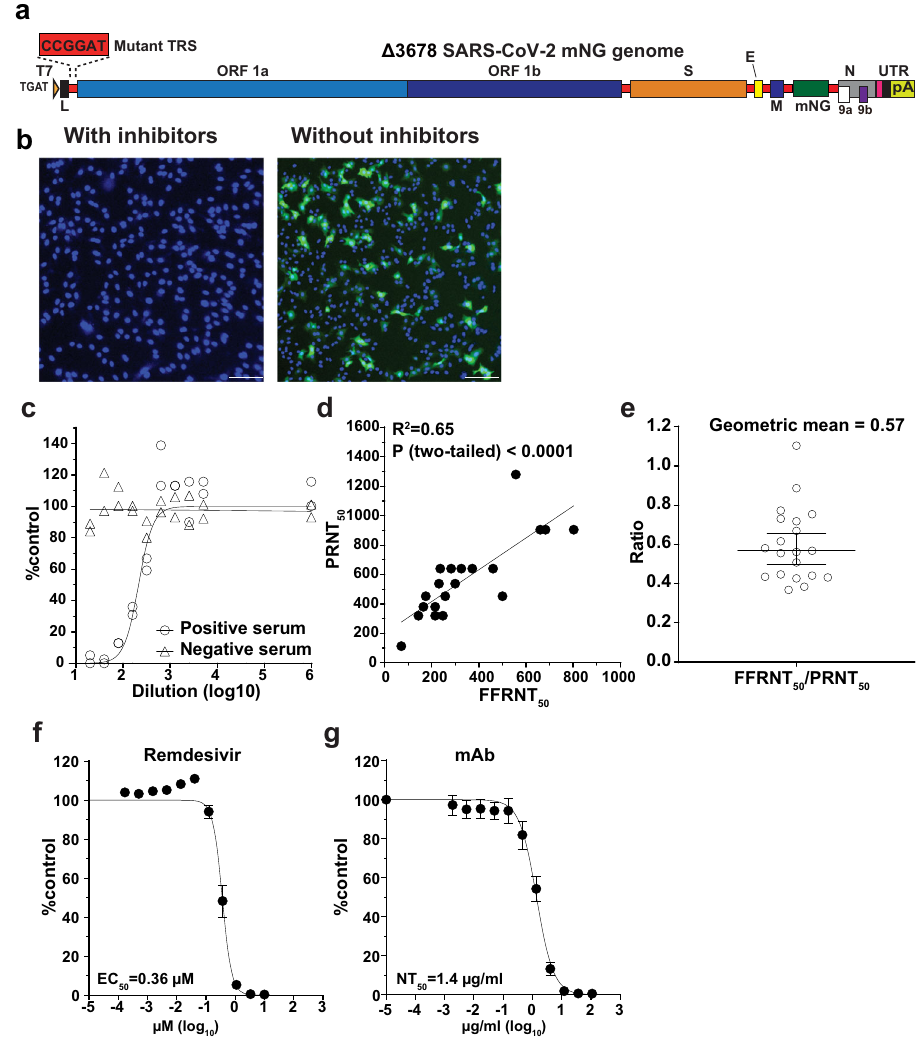
Fig. 6 | Development of mNG Δ 3678 virus for high-throughput neutralization and antiviral testing. a Genome structure of mNG Δ 3678 SARS-CoV-2. The mNG genewasinsertedbetweenMandNgenes. b mNGfociofA549-ACE2cellsthatwere infected with mNG Δ 3678 SARS-CoV-2 in the presence and absence of 10 µ M inhi- bitor (remdesivir) for 24h. Scale bar, 100 µ m. c Representative FFRNT neutraliza- tion curves for a COVID-19 antibody-positive and -negative serum. d Correlation between FFRNT 50 with PRNT 50 values of 20 COVID-19 convalescent sera. The Pearson correlation (two-sided) ef fi ciency and P value are shown. e Scatter-plot of